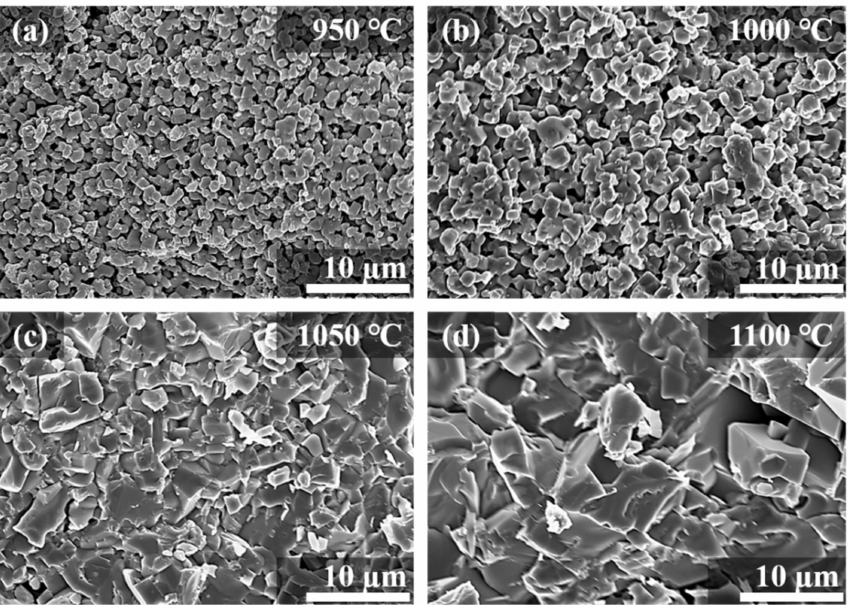
Figure 4. FE-SEM images of LASTP-X pellet sintered at various temperatures ( a ) 950 ◦ C, ( b ) 1000 ◦ C, ( c ) 1050 ◦ C, and ( d ) 1100 ◦ C. The dependence of the relative density on the sintering temperature was examined.